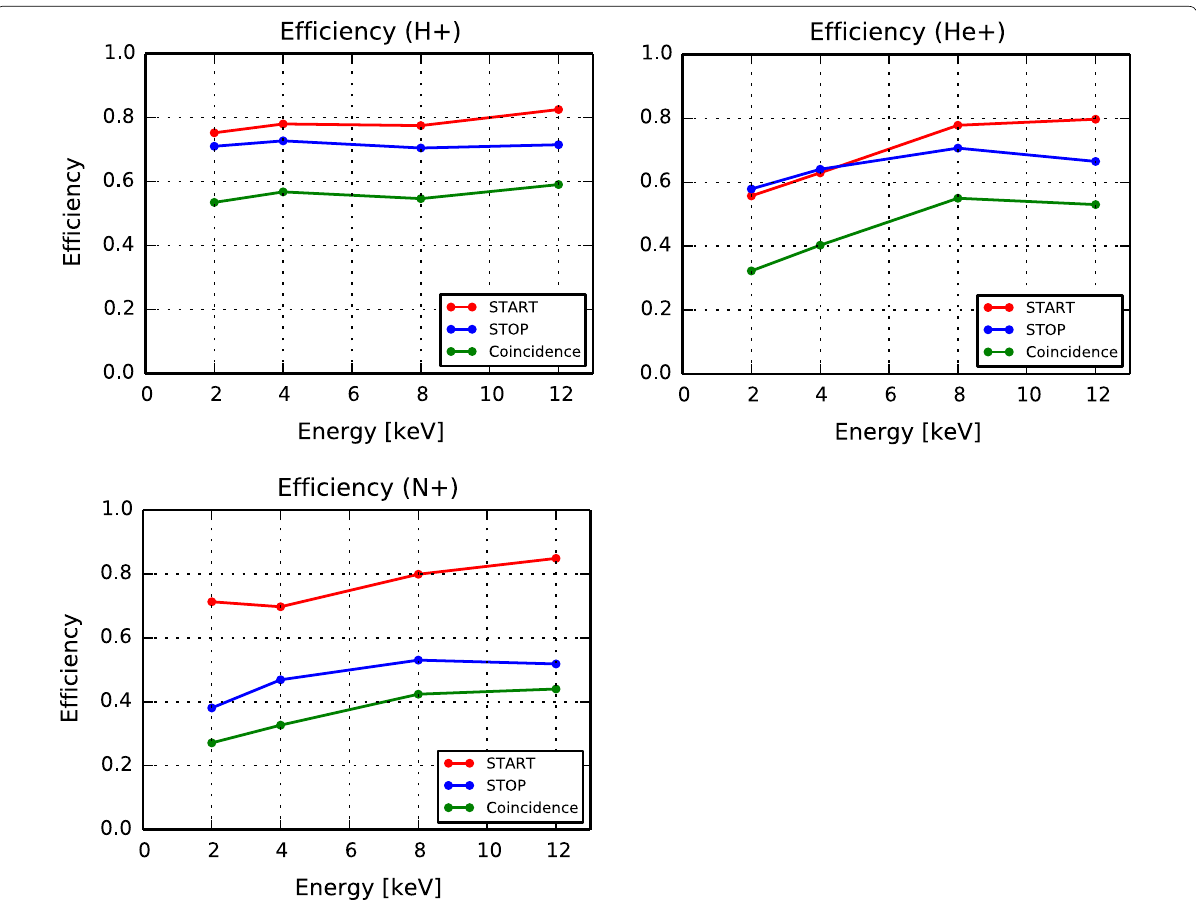
Fig. 12 Typical detection efficiencies of azimuthal channel 3 for incident ions (STOP) and secondary electrons (START) based on the laboratory experiment. The coincidence efficiency is the product of START and STOP